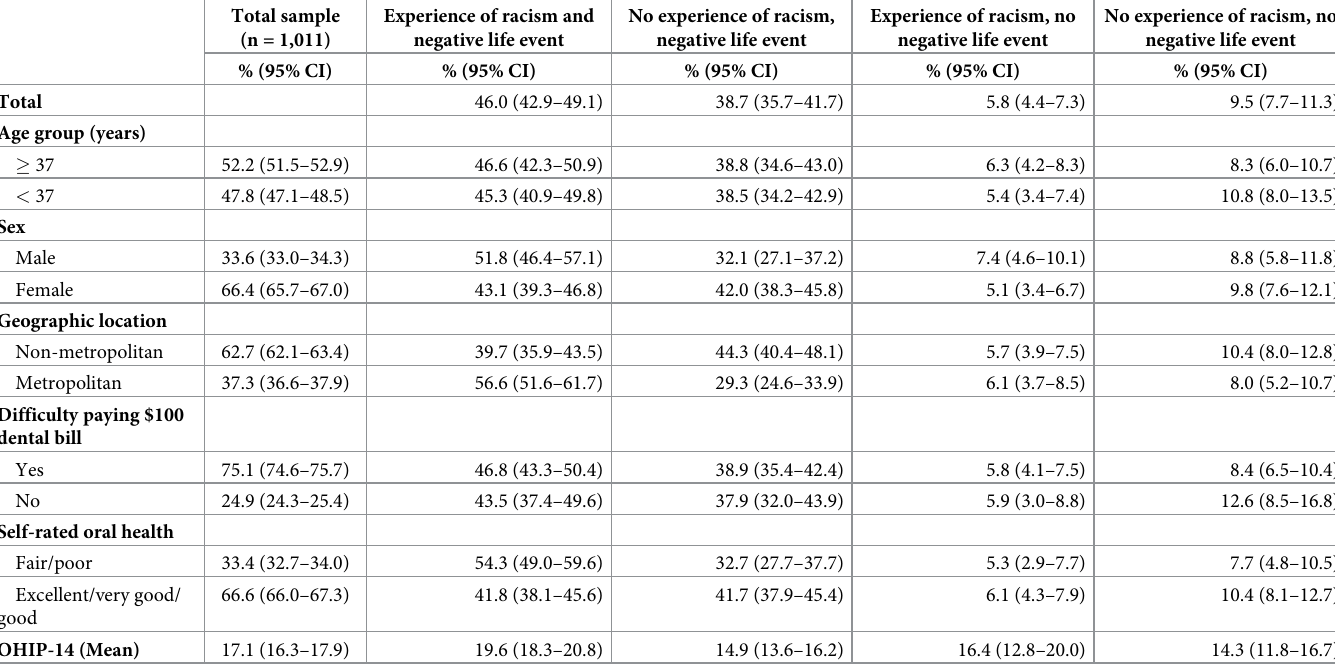
Table 2. Associations between racism, negative life events and poor oral health outcomes, Indigenous South Australian adults, 2018–2020. Total sample (n = 1,011)